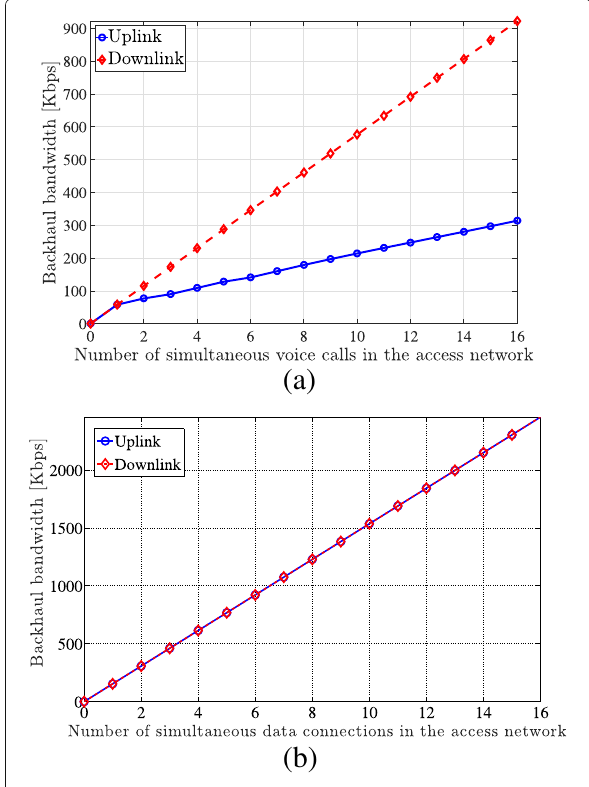
Fig. 7 Backhaul bitrates for voice and data connections. a Backhaul bitrates according to the number of voice connections. b Backhaul bitrates according to the number of data connections